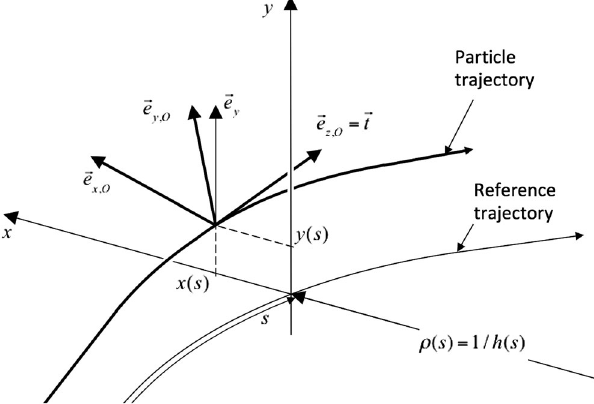
FIG. 3. Coordinate system attached to the trajectory of the particle and used to describe the